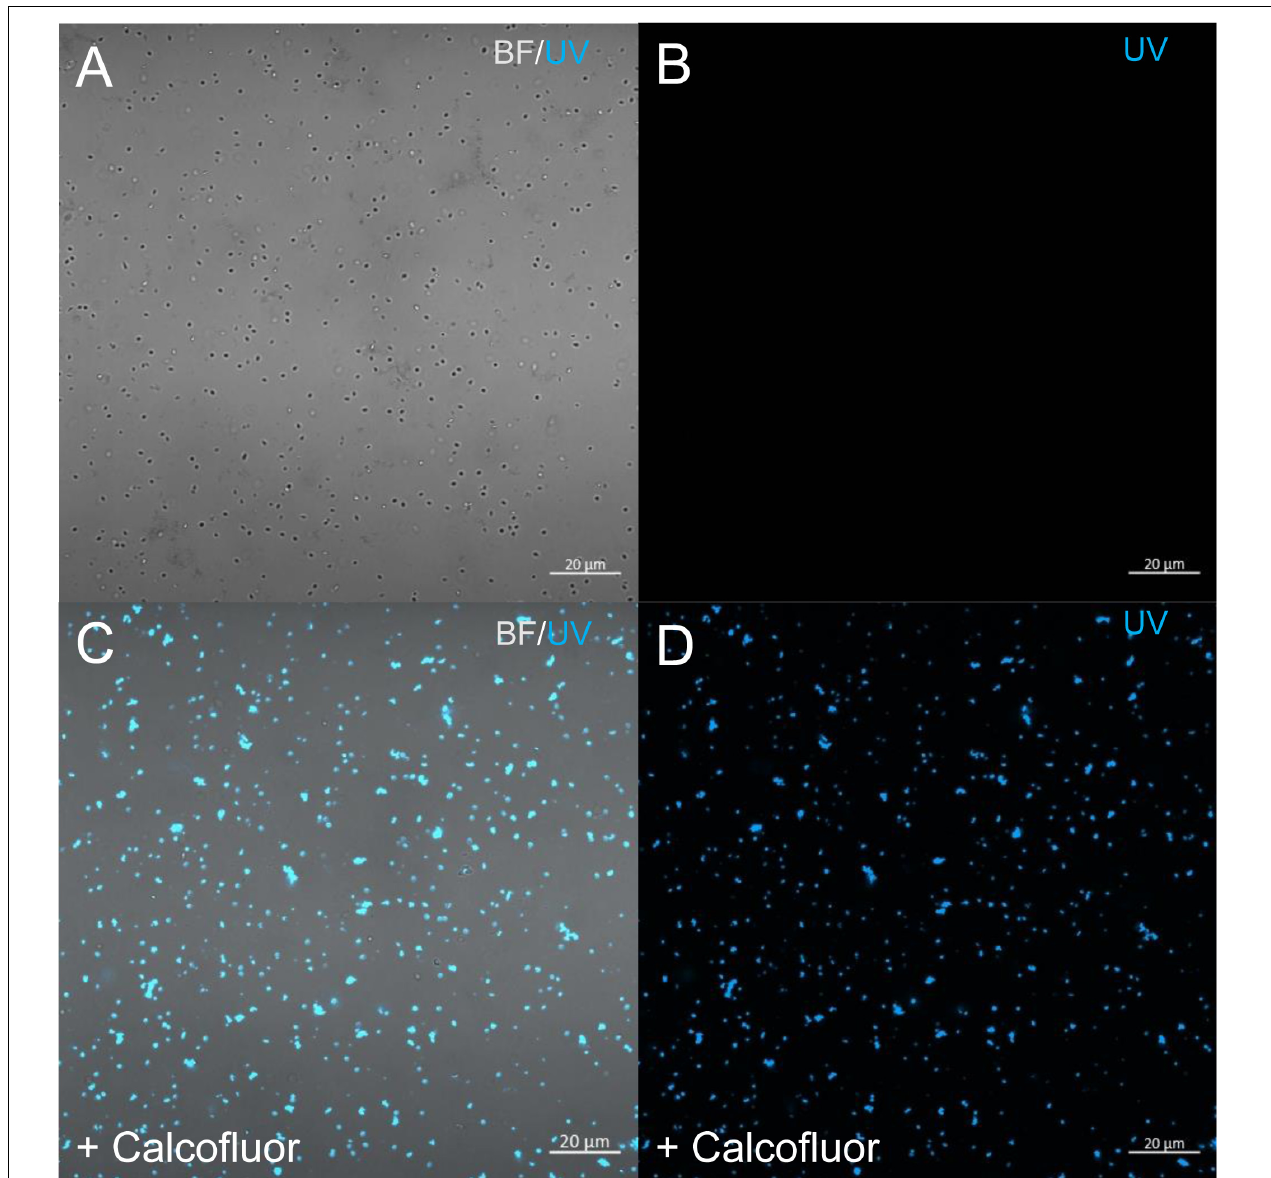
FIGURE 5 | Confocal imaging of Calcofluor staining of P. massiliensis . (A,B) Control Pandoravirus particles. (C,D) Calcofluor-stained Pandoravirus particles. (BF: brightfield; UV: